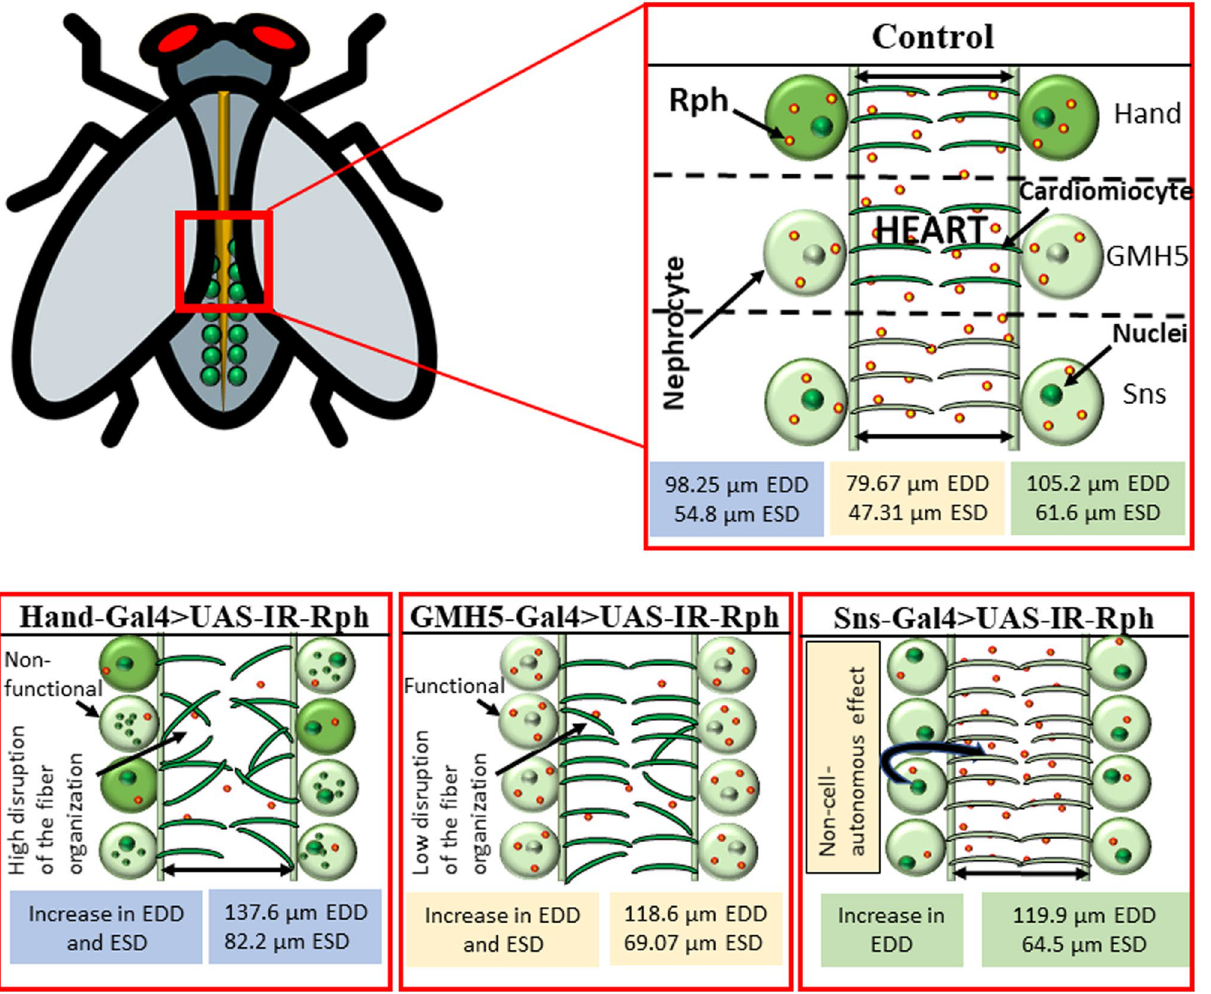
Figure 7. Graphical model of the cardiac alterations due to the silencing of Rph in heart and pericardial nephrocytes in Drosophila . RNA interference of Rph expression in the heart and nephrocytes ( Hand-Gal4 driver) and only in the heart ( GMH5-Gal4 driver) promotes an increase of EDD and ESD, disorganization of circumferential cardiac fibers, and a reduction in survival. Silencing of Rph expression in nephrocytes ( Sns-Gal4 driver) causes an increase in EDD, which reveals a paracrine effect of nephrocytes in the heart tube functioning. Text framed in blue, light red, and green indicates data coming from Hand-Gal4 , GMH5-Gal4, and Sns-Gal4 drivers, respectively. The big green dots surrounding the heart are the nephrocytes, and the smaller green dots inside represent the nuclei. The even smaller green dots that can be seen inside the nephrocytes when using Hand-Gal4 driver represent the diffuse GFP signal characteristic of non-functional nephrocytes. The yellow/ red dots represent Rabphilin inclusions. Finally, the transversal lines that are inside the heart represent the circumferential cardiac fibers. The intensity of the green colour indicates the tissue in which the corresponding Gal4 construct drives the interference, being more intense in the places where it drives the interference most. Although in control flies we did not perform Rph interference, we did use the Gal4 drivers and the same colour convention is employed to denote the expression